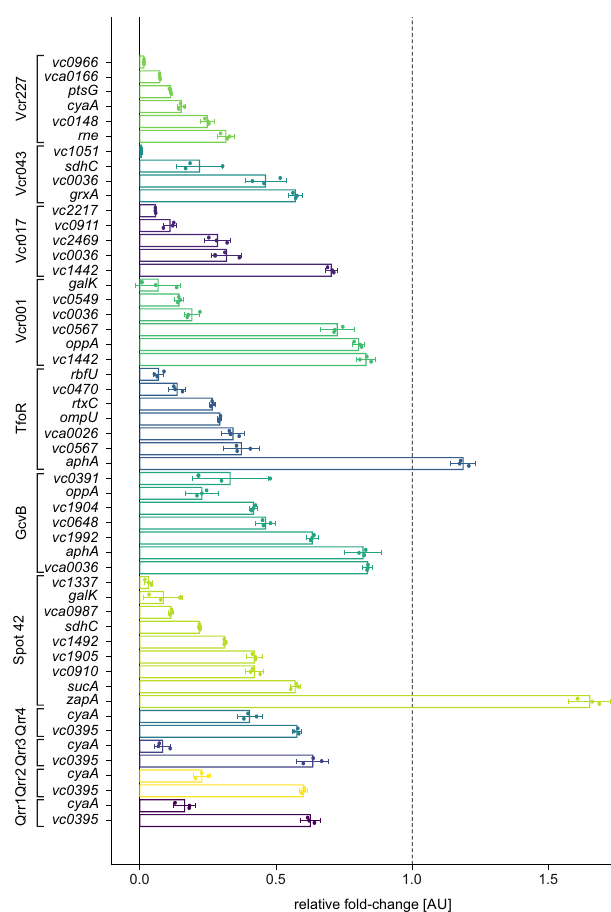
Fig. 1 | RIL-seq analysis of Hfq in V. cholerae . A , B Circos plots visualizing Hfq- mediated RNA-RNA interactions. V. cholerae hfq::3XFLAG cells were cultivated to low (OD600 of 0.2) ( A ) and high cell density (OD600 of 2.0) ( B ) and subjected to RIL-seq analysis. Top 500 signi fi cant chimeras are shown and previously reported and sRNAs relevant to C are indicated. The fi rst and the second chromosome are markedindarkandlightgreen,respectively.Circosplotsweregeneratedusingthe circos component of the Dash Bio package. C Validation of sRNA-mRNA